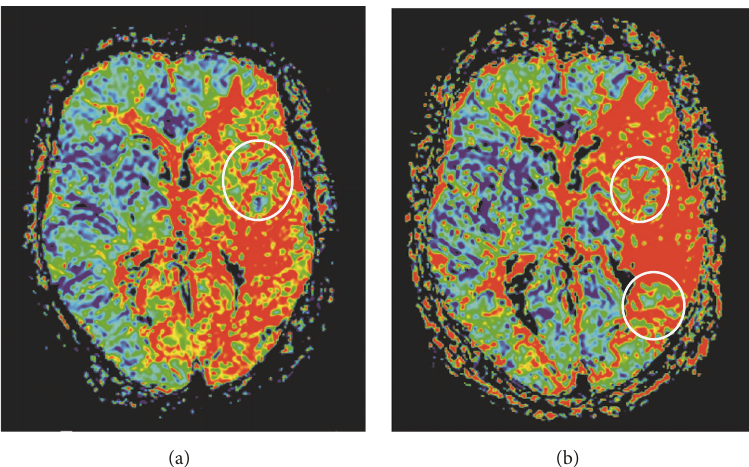
Figure 3: Perfusion weighted imaging prior to and after therapy. Prior to therapy (a): prolonged mean transit time in large parts of the left middle cerebral artery territory as well as both posterior cerebral artery territories and an area with only moderately elevatedtransit time was found in the left insular cortex (white circle). After endovascular therapy (b): improvement of cerebral perfusion in both posterior cerebral artery territories and partly the left middle cerebral artery territory, with a now moderately elevated transit time in the border zone between middle and posterior cerebral artery territories, in addition to the area in the insular cortex (circles).